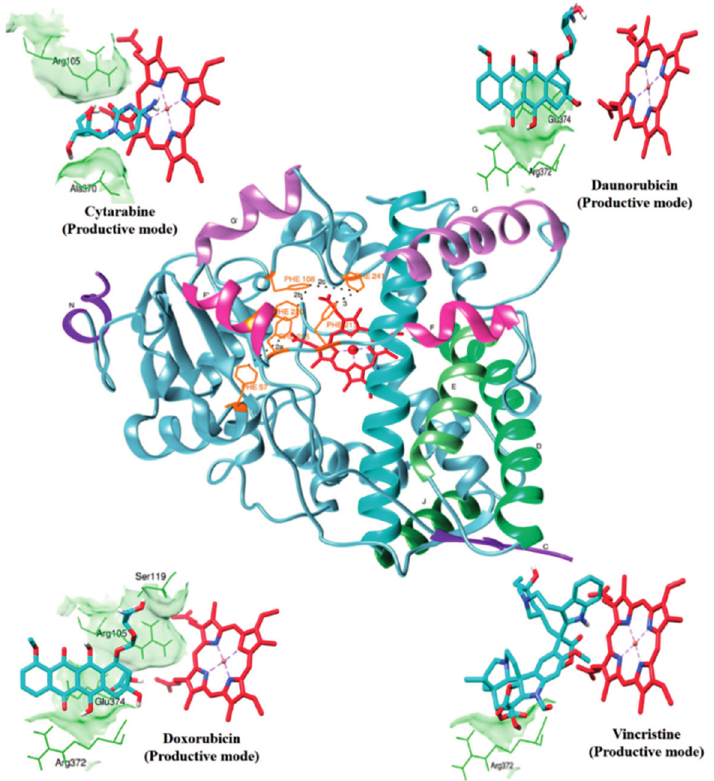
Figure 1. Productive binding modes of cytarabine, daunorubicin, doxorubicin and vincristine docked with CYP3A4 are shown. The overall fold of CYP3A4 is shown in the center. Only the heme (red color in stick representation), drugs (cyan color in stick representation) and hydrogen bonding residues (green color in line representation) are shown. A few hydrogen bonding residues are not shown for